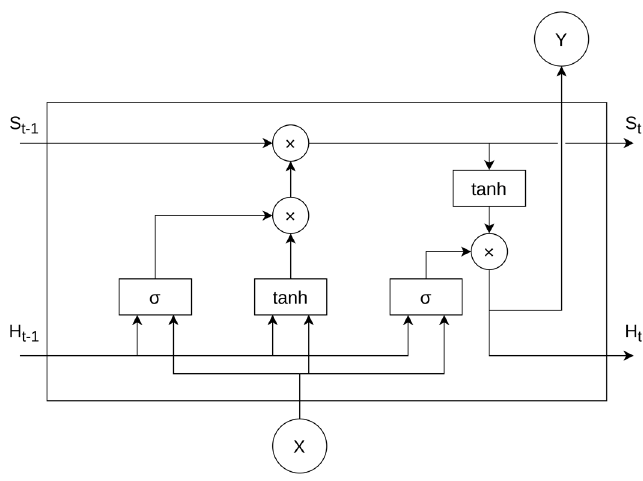
Figure 7. Schematic of an RNN cell.